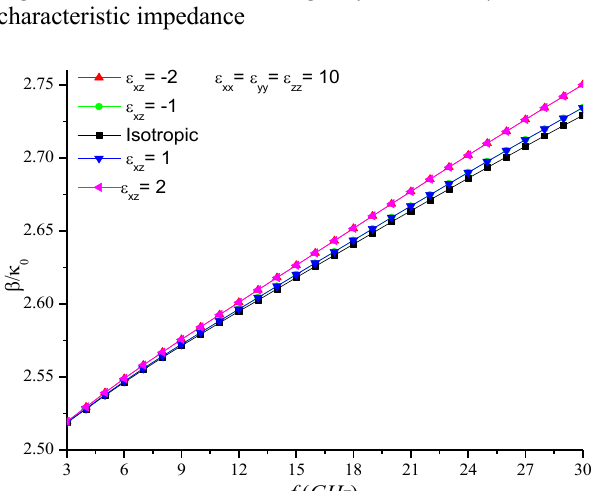
Figure 8.b: Effect of imaginary valued e yz on the characteristic impedance